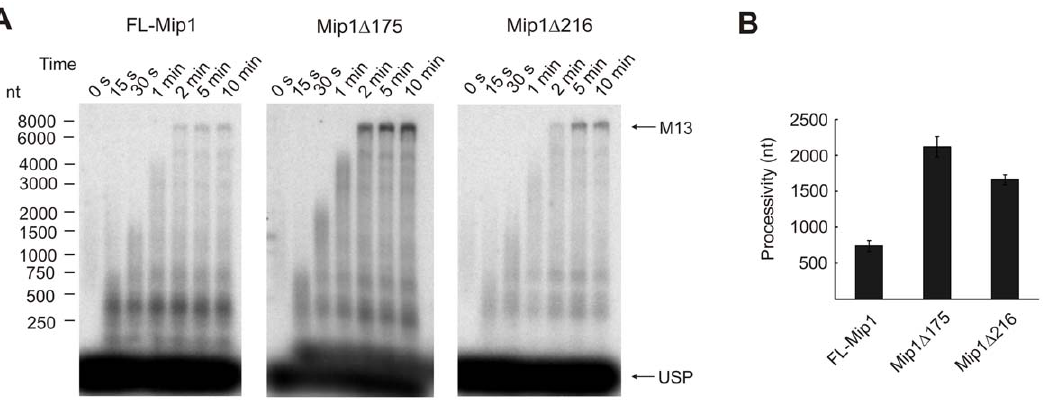
Figure 4. Processivity of Mip1 and C-terminal deletion mutants. Processivity was measured under single-hit conditions with 4 nM of substrate M13 ssDNA singly primed with radiolabeled USP and 1 mg/ml calf thymus activated DNA. The reaction was performed at 30 u C with 4 nM DNA polymerase in the presence of 100 m M dNTP. The reaction was stopped with 0.5 mg/ml Proteinase K, 1% SDS, 20 mM EDTA after indicated time points. A. Reaction products were separated on 0.8% alkaline agarose gel. Arrows indicate positions of M13mp18 unit length (7250 nt) and 17 nt USP. B. Processivity of FL-Mip1, Mip1 D 175 and Mip1 D 216 was calculated as the average length of the product (nt) synthesized by the polymerase per one binding event. Weighted mean method based on the product intensity and length was used for analysis. Data from three independent experiments was used to calculate the average processivity and standard deviation values.